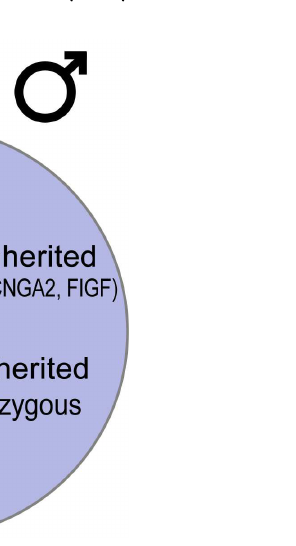
Fig 3. Summary diagram of the variations found in the two